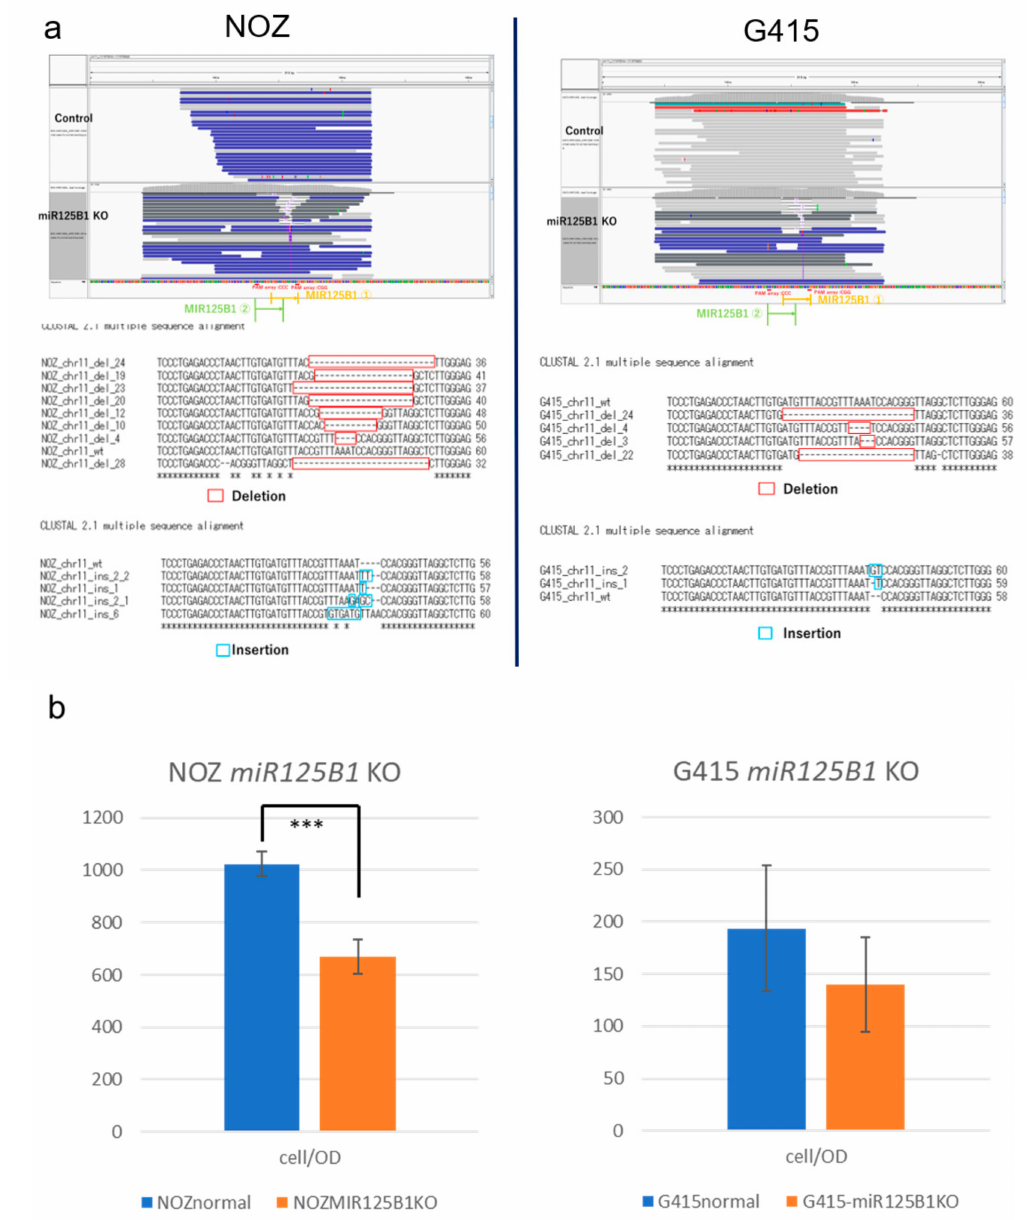
Figure 5. Knockout of miR125B in GBC cell lines. ( a ) The genomic region of miR125B was edited by CRISPR technology. This region was amplified by PCR from DNA of the edited and control cells of NOZ (left) and G415 (right) and sequenced by MiSeq. The IGV pictures are shown (upper). Deletion or insertion reads in miR125B were observed (bottom). ( b ) Cells that invaded through the Matrigel were counted three times to calculate average cells per membrane. The triplicate of the average of the calculated difference between the test measurement and reference measurement was used as the OD. We calculated cell/OD as an index of invasion per unit area corrected by the number of seeded cells, to compare cell/OD values between miR125B1 knockout NOZ and G415 cell lines ( p = 0.00124 and 0.14466 by t -test,